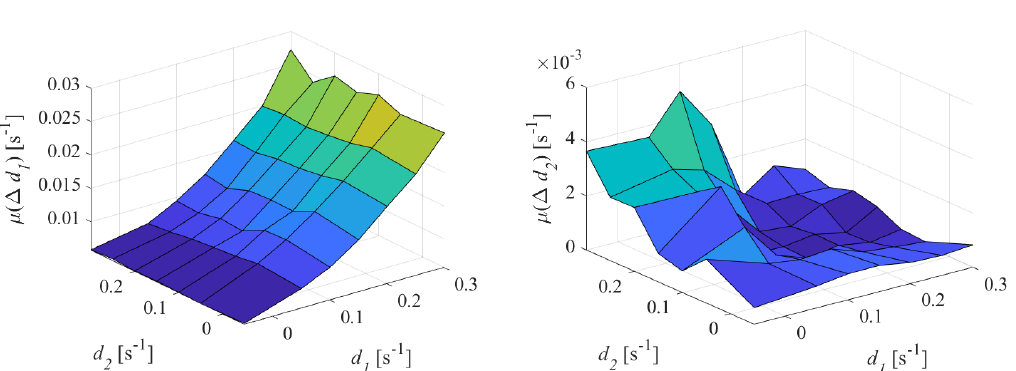
Figure 13. Mean of ∆ d versus damping coefficients obtained in experimental tests with digitized signals; results for frequency f 1 ( on the left ) and f 2 ( on the right ).